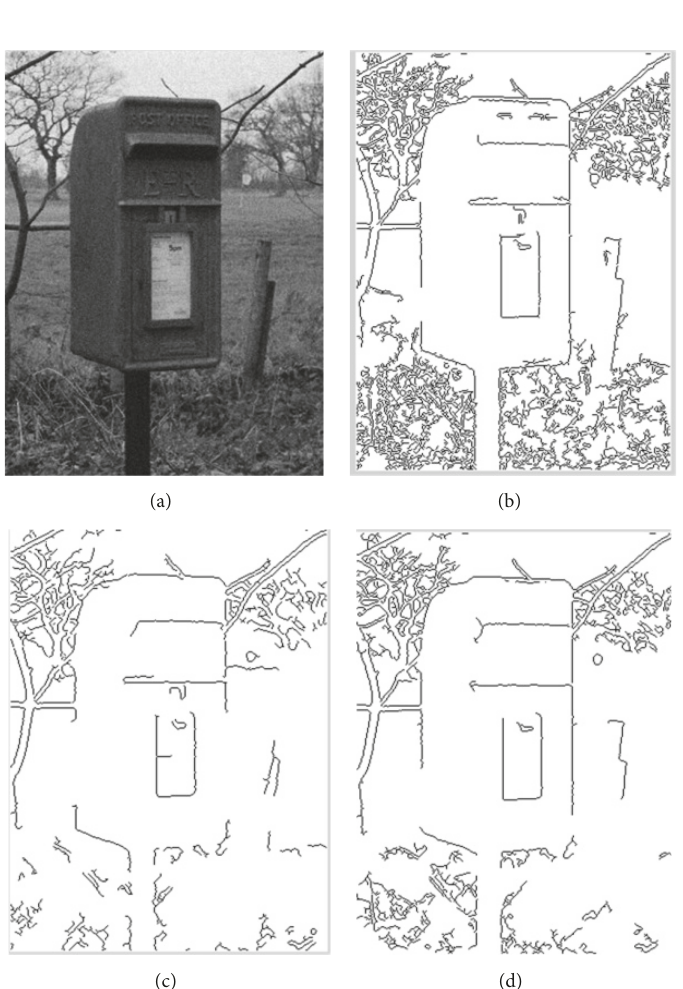
Figure 3: Results of edge detection under different scales. (a) Image with white Gaussian noise, (b) Sobel edge detection with scale 𝑁 𝑘 = 3 , (c) Sobel edge detection with scale 𝑁 𝑘 = 7 , and (d) fused edge detection with